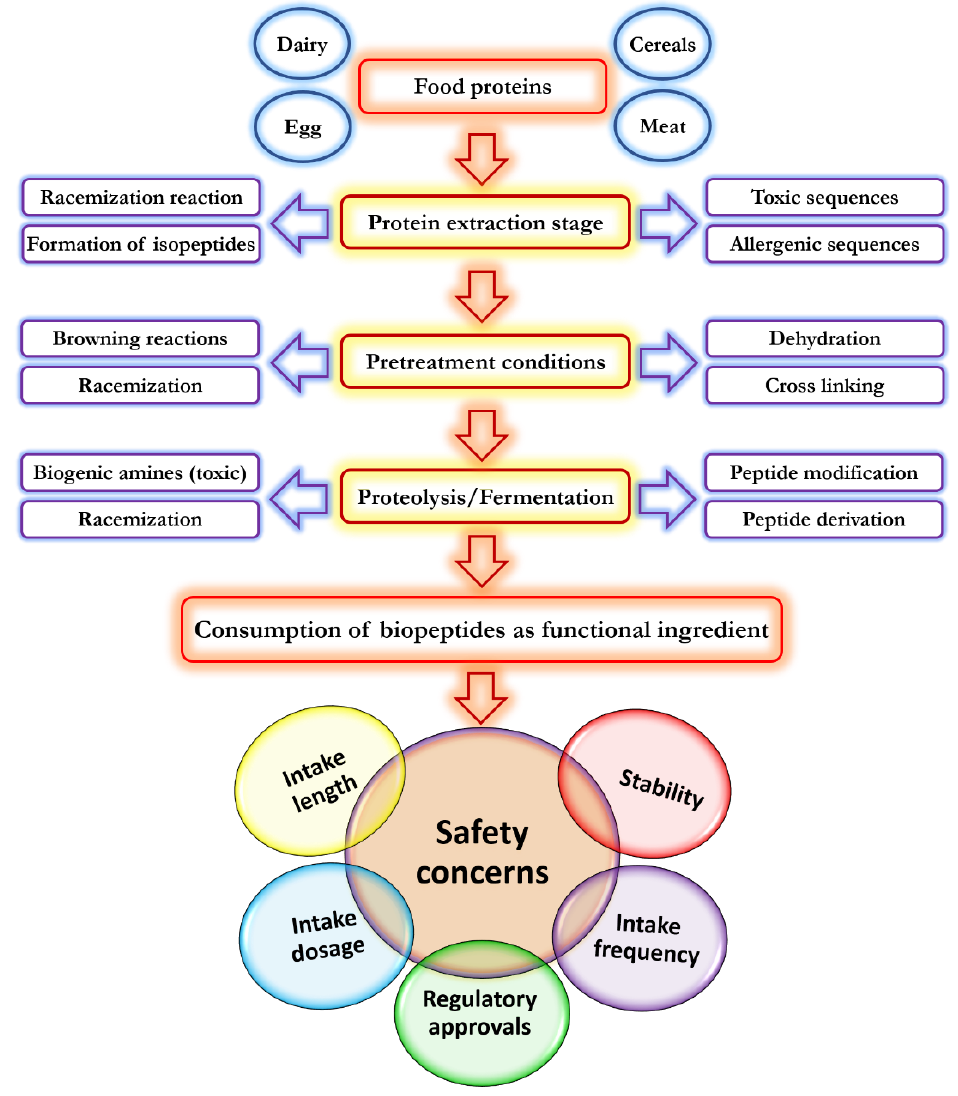
Figure 3. Safety concerns and hazards during preparation, storage, and consumption of bioactive peptides.